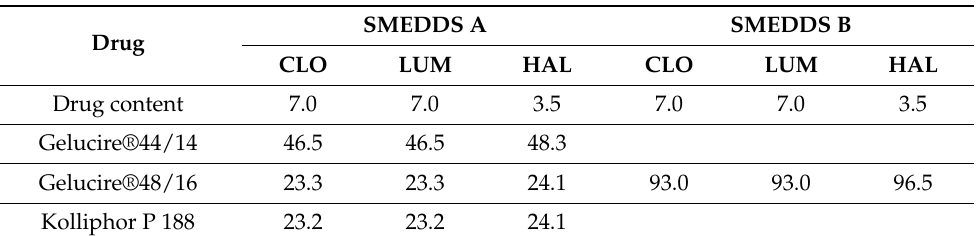
Table 5. Compositions of the two different drug-loaded SMEDDS formulations used for the multi- compartment systems.